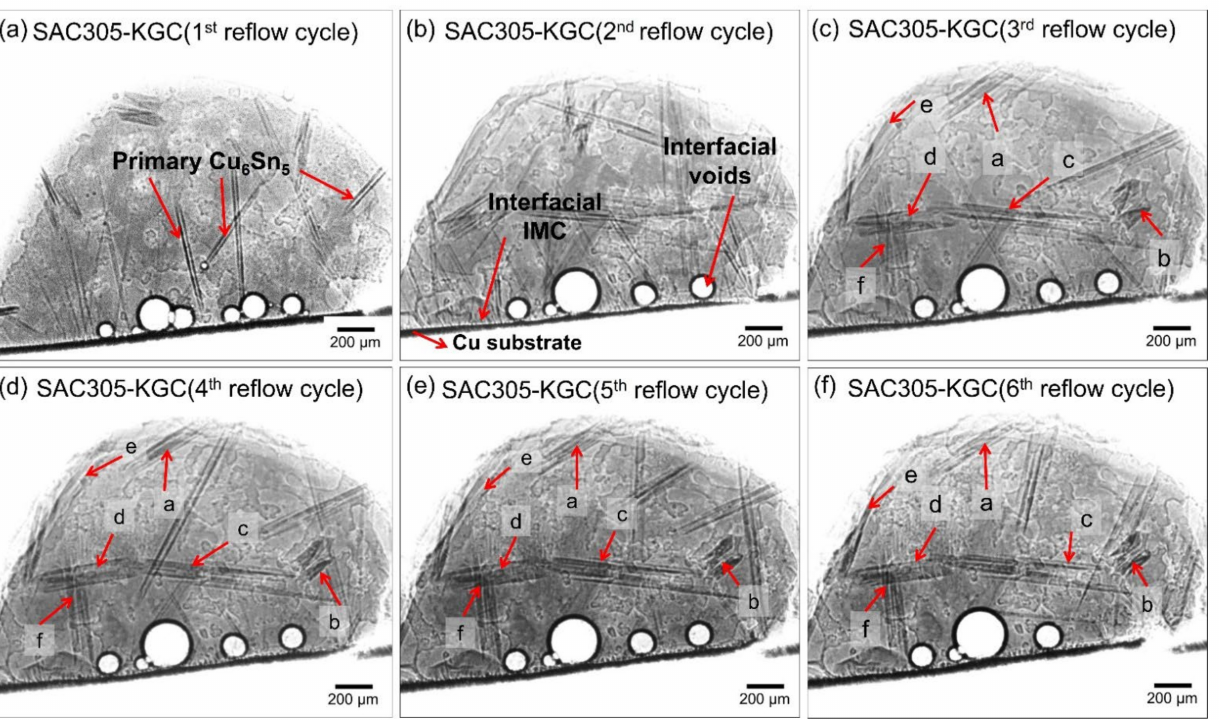
Figure 7. Synchrotron radiation images of SAC305-KGC showing the formation of primary Cu 6 Sn 5 IMC with respect to multiple cycles of reflow